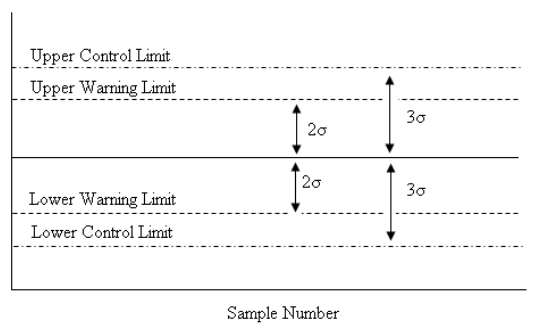
Fig. 1. A traditional control chart with its warning and control